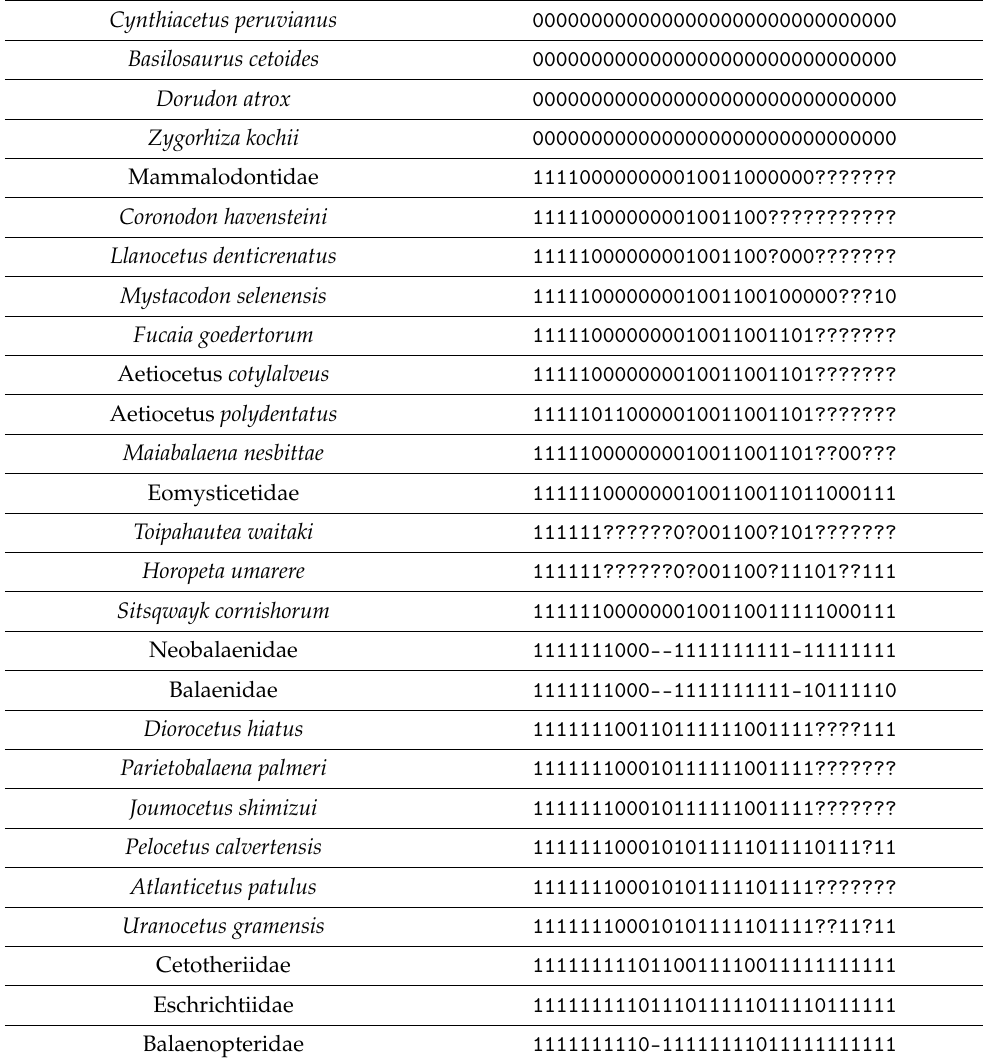
Table 3. Character x taxon matrix used in the analysis of character distribution and inference of character states at ancestral